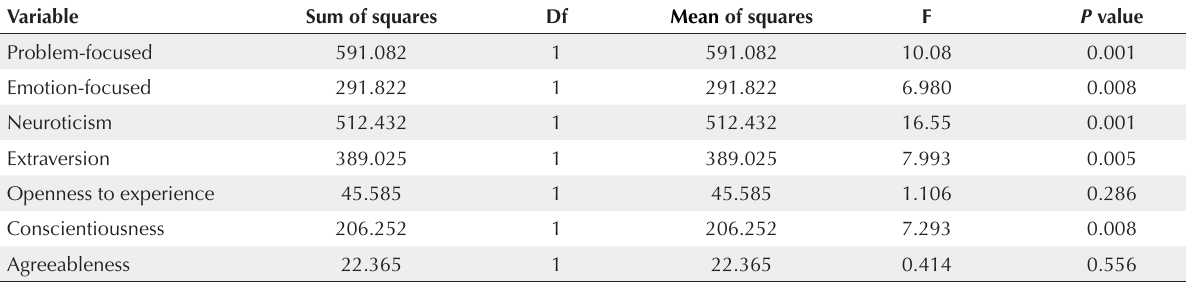
Table 3. Results of MANOVA for coping styles and personality traits variables Variable Sum of squares